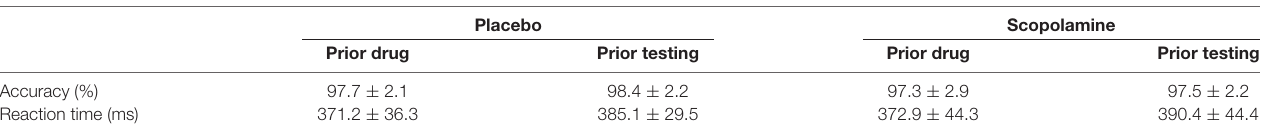
TABLE 2 | Reaction time measure to assess changes in